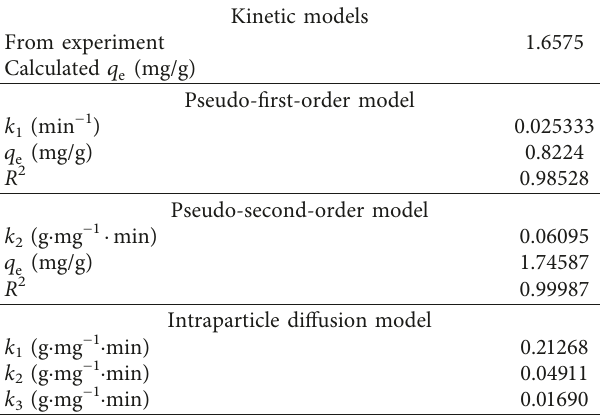
Figure 8: Plot of the (a) pseudo-first-order model, (b) pseudo-second-order model, and (c) intraparticle diffusion model. Table 2: Parameters of kinetic models of MB adsorption on the